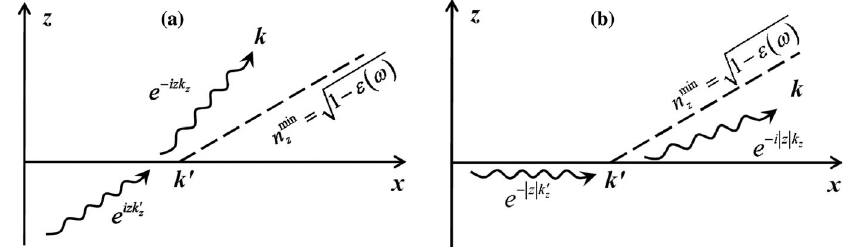
FIG. 3. X-ray radiation leaves the target refracting at its upper facet: (a) the “ volume ” wave exp ð izk 0 z Þ , z < 0 , refracts at the surface and goes out at the angle more than θ cr that is defined by Eq. (25); (b) the evanescent wave exp ð − j z j k 0 z Þ , z < 0 , gives the radiation (exp ð − izk z Þ , z > 0 ) at the angle less than θ cr